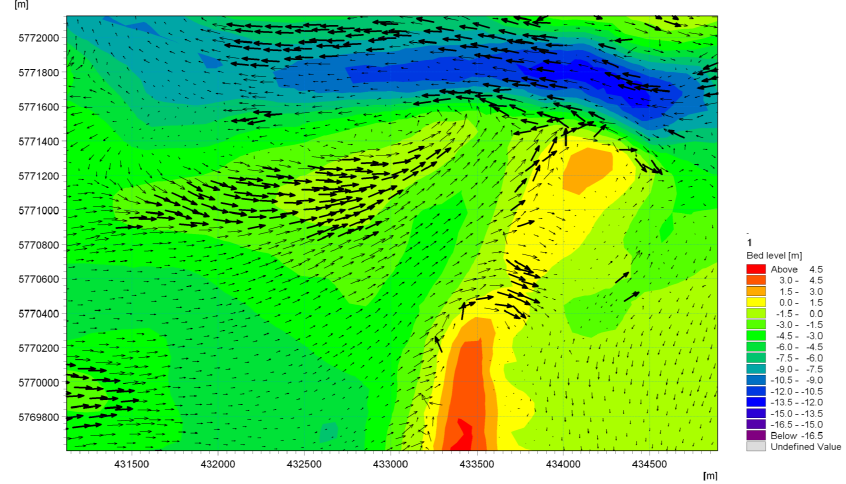
Figure 13. Simulated Accumulated Sediment transport vectors for Grain Size Trend Analysis (GSTA) comparison. (GSTA)